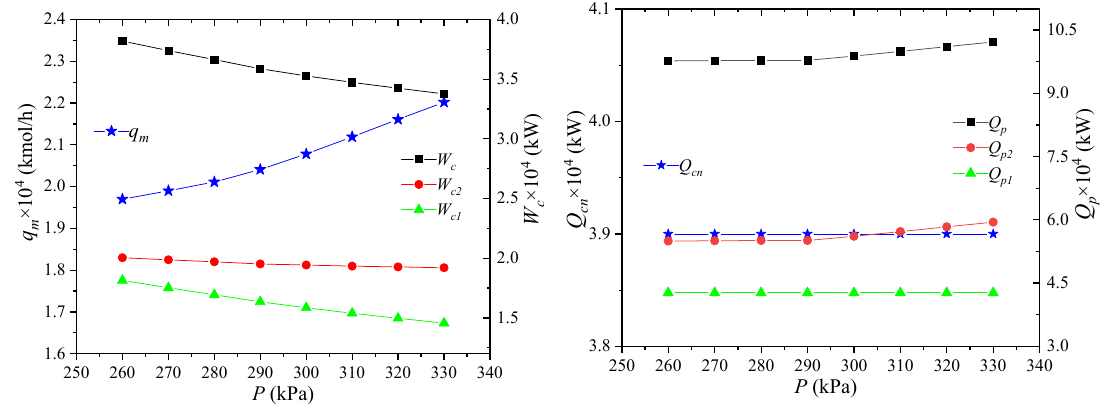
Figure 8. E ff ects of low-pressure mixed refrigerant pressure on process